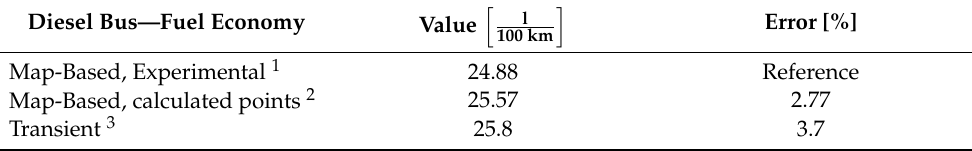
Table 3. WHVC: Diesel bus fuel economy comparison.